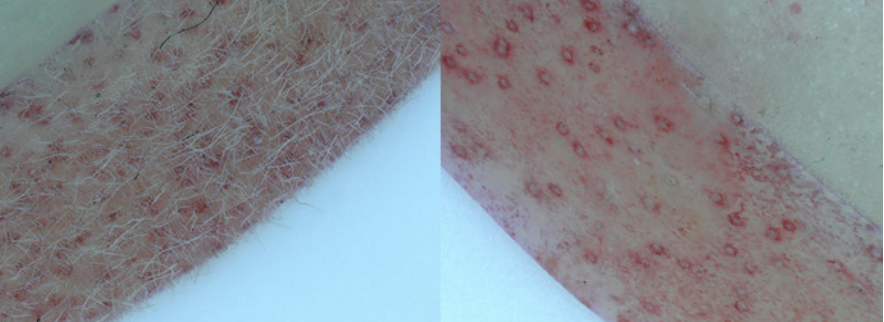
Figure 1. Comparing the differences between hairy fruit skin ( left ) and non-hairy skin ( right ) observed using a zoom-stereo microscope at a magnification of 30 ×.